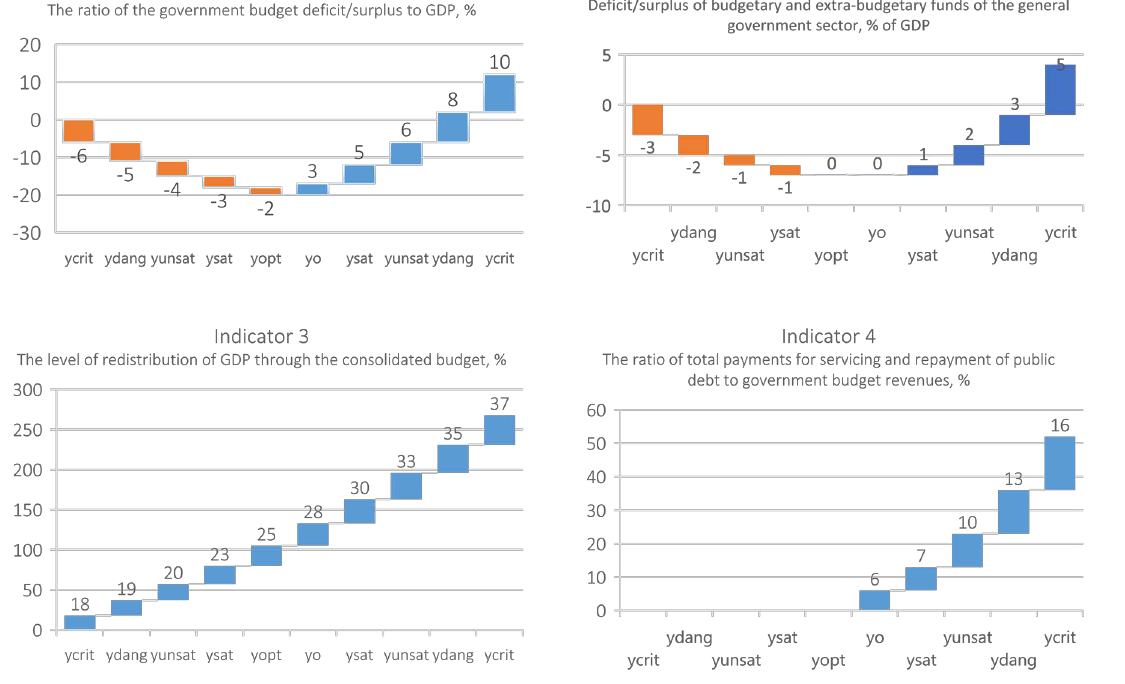
Figure 1. Range of eigenvalues of budget security